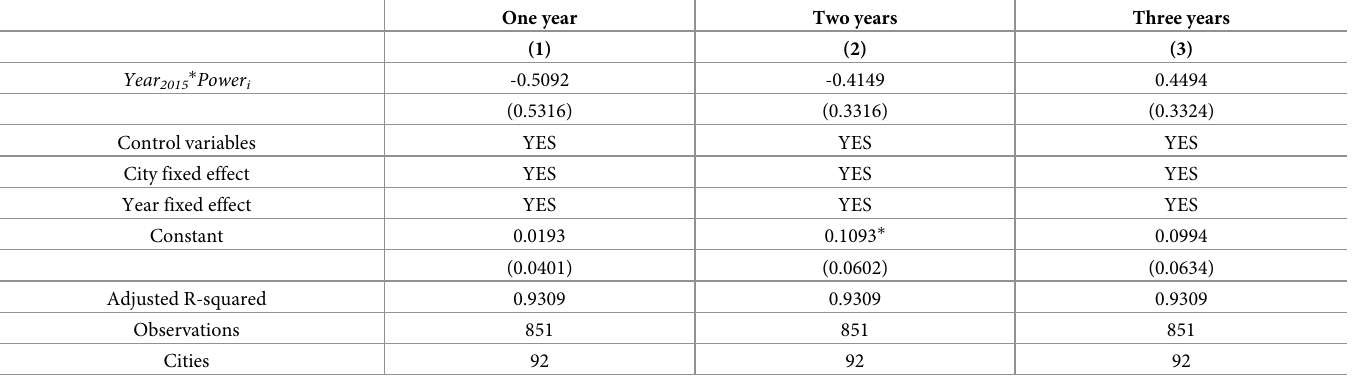
Table 3. Placebo